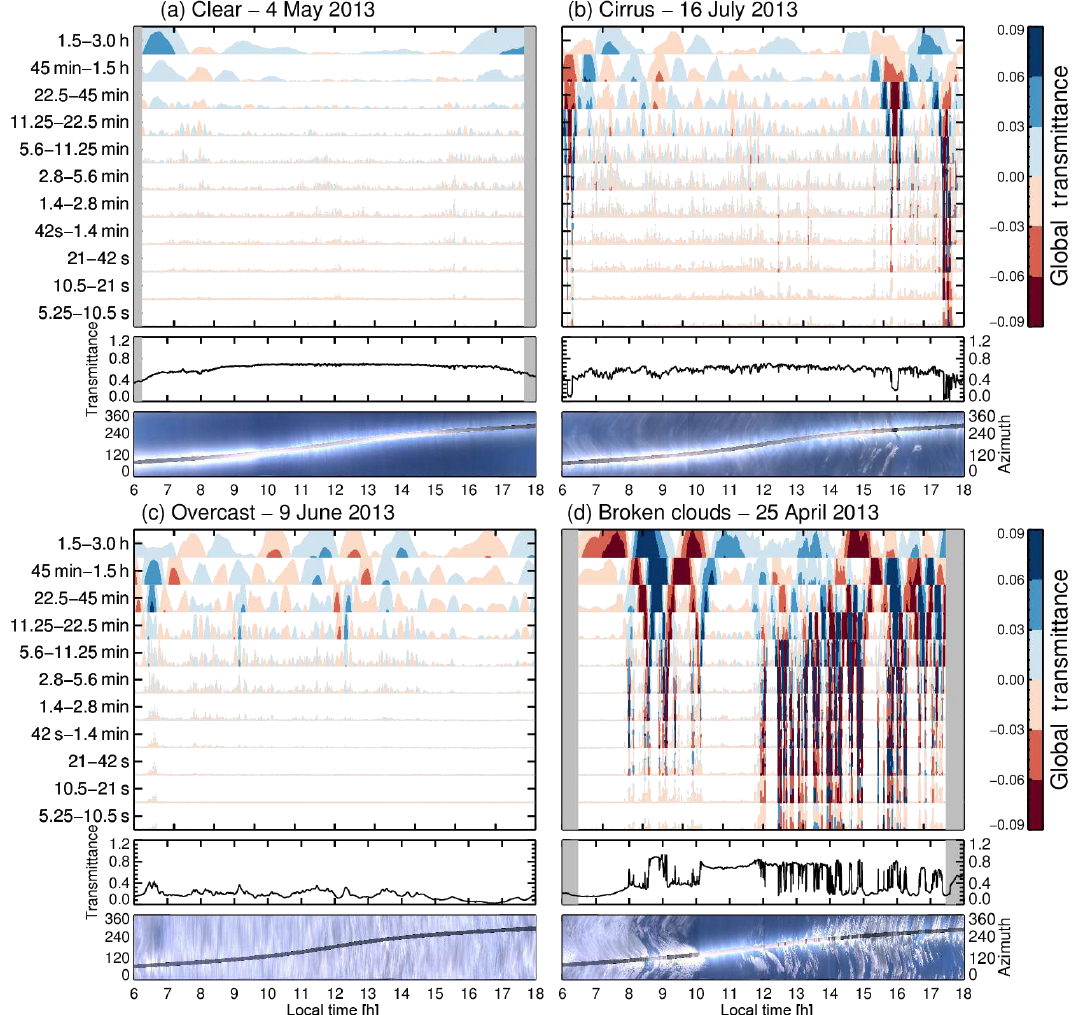
Figure 3. Horizon graphs for MRA of global transmittance from a pyranometer station at FZJ during the HOPE campaign represented as a function of local time (in h) for different sky conditions: (a) clear – 4 May 2013, (b) cirrus – 16 July 2013, (c) overcast – 9 June 2013, and (d) broken clouds – 25 April 2013. The top panels represent the horizon plots of transmittance details. Middle panels represent the original time series of transmittance. The t –azi plots of the sky imager at 45 ◦ elevation angle are shown in the bottom panels. Shaded gray color in the top and middle panels of (a) and (d) corresponds to the region with solar zenith angles > 75 ◦ . A horizon graph is constructed by dividing a normal line plot into bands defined by uniform value ranges. The bands are then layered to reduce the chart height. Negative values (red bands) can be mirrored or offset onto the same space as positive values (blue bands) such that the colors are differentiated. These layered bands are nested together. Such a visualization allows us to identify extraordinary behaviors or predominant patterns, view changes, interpret each of the time series independently from the others, and perform comparisons between the different temporal periods (Few,